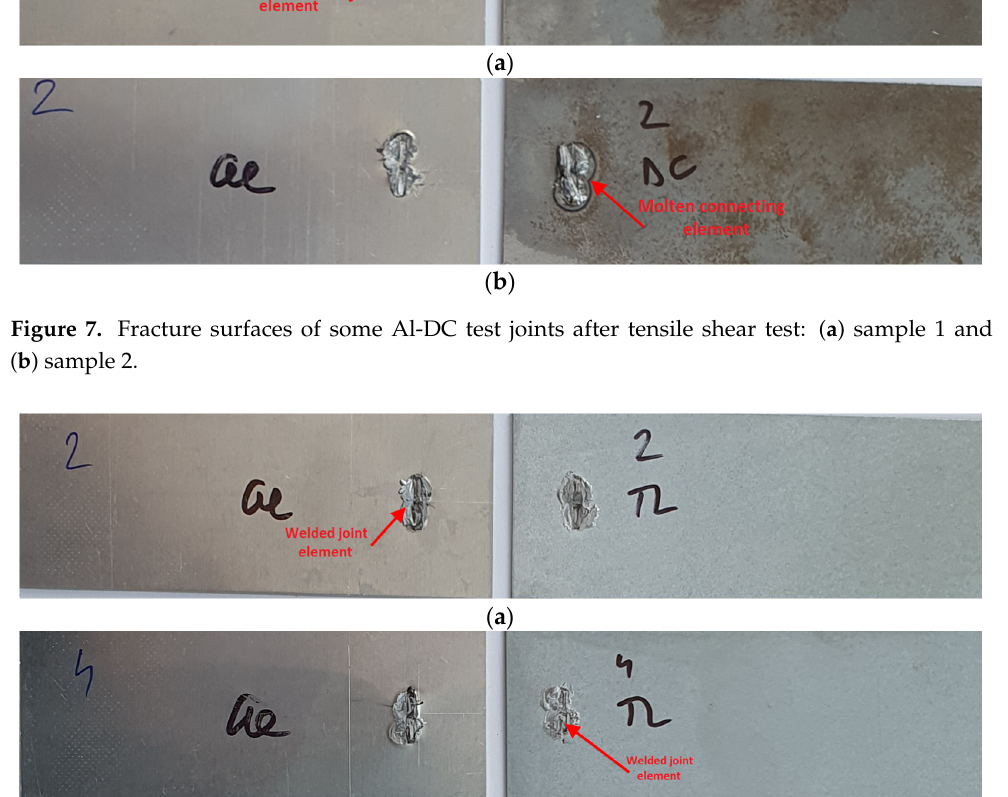
Figure 7. Fracture surfaces of some Al-DC test joints after tensile shear test: ( a ) sample 1 and ( b ) sample 2.